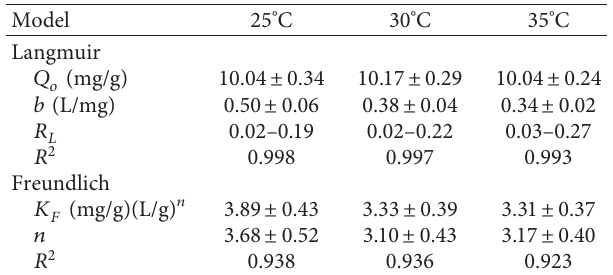
Table 5: Equilibrium isotherm parameters for the adsorption of Cr(VI) onto